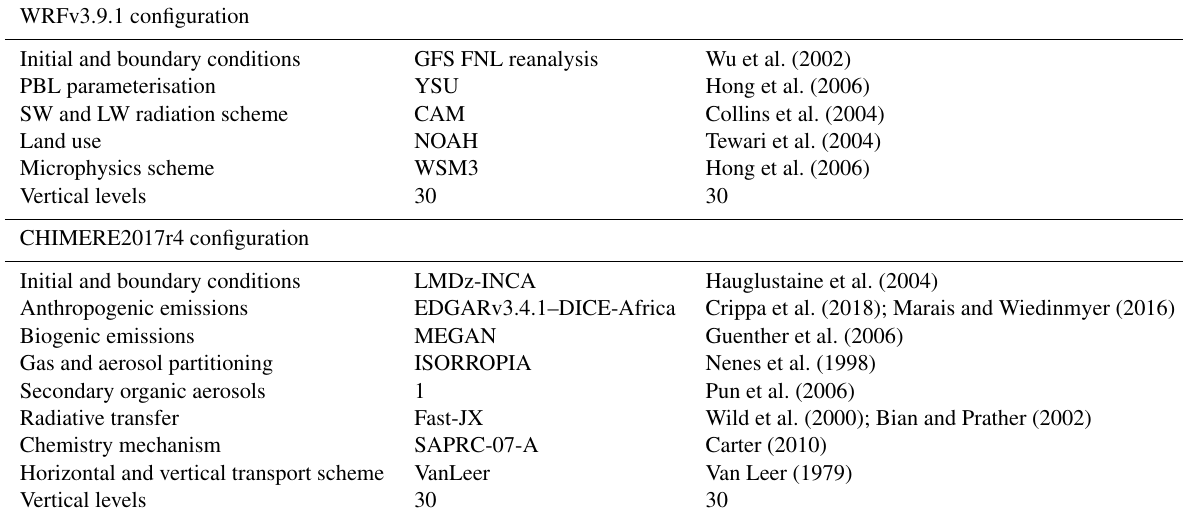
Table 1. Main configuration parameters adopted for the WRF–CHIMERE modelling system for all